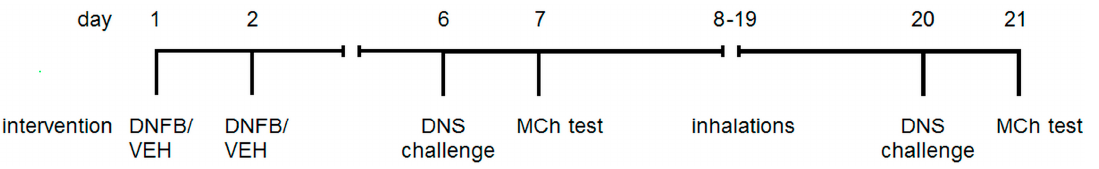
Figure 6. The outline of the experiment. DNFB, skin sensitization with 1-fluoro-2, 4-dinitrobenzene; VEH, skin sensitization with vehicle (acetone: olive oil 4:1 v / v ); DNS, intratracheal challenge with dinitrobenzene sulfonic acid; MCh, test with increasing concentrations of